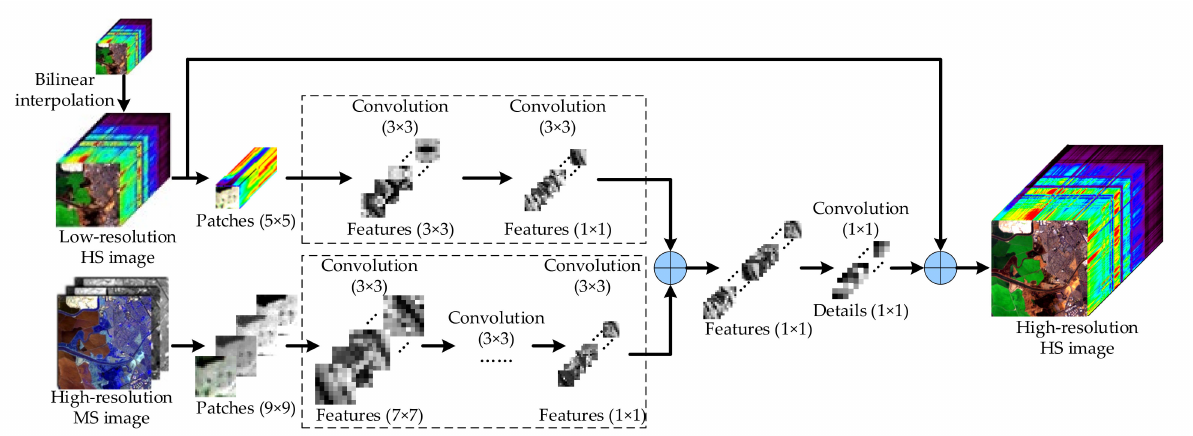
Figure 1. The main framework of the proposed